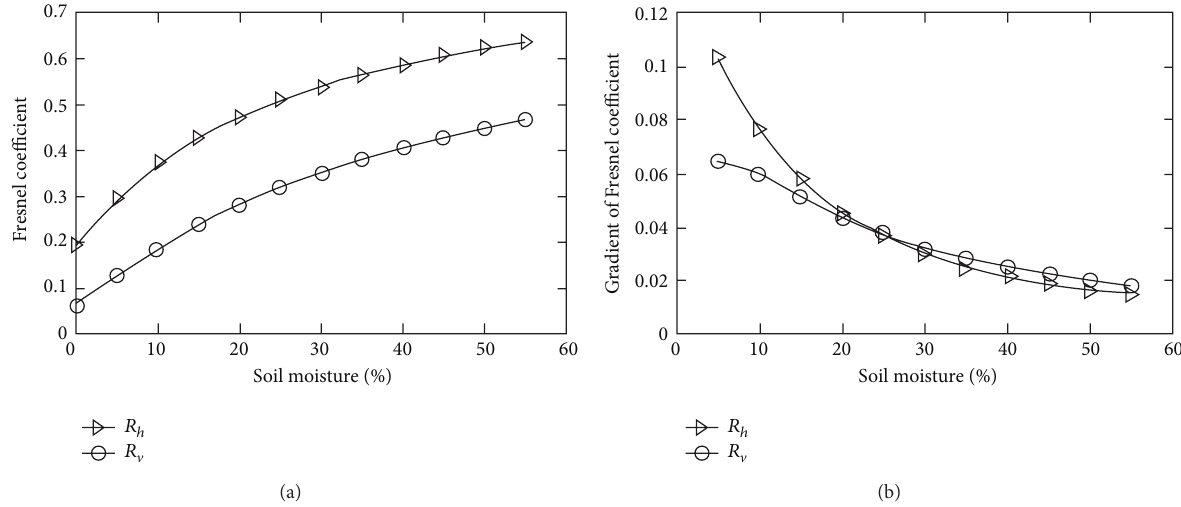
Figure 9: Relationship between the Fresnel coefficients and the gradient of the Fresnel coefficients with a variation in soil moisture.